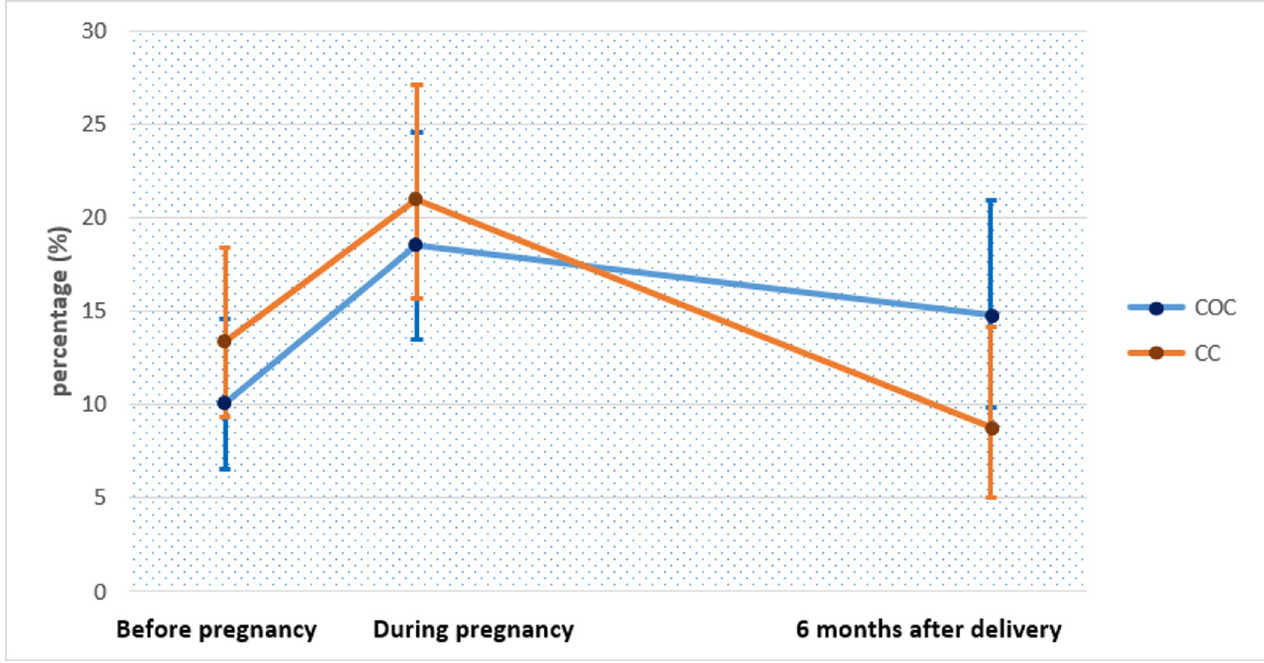
Fig 2. Evolution of the proportion (%) of high involvement of male partner in sexual and reproductive health of the couple by counselling group among pregnant women cohort, in Yaounde, Cameroon, ANRS 12127-12236/Prenahtest trial (2009–2011).